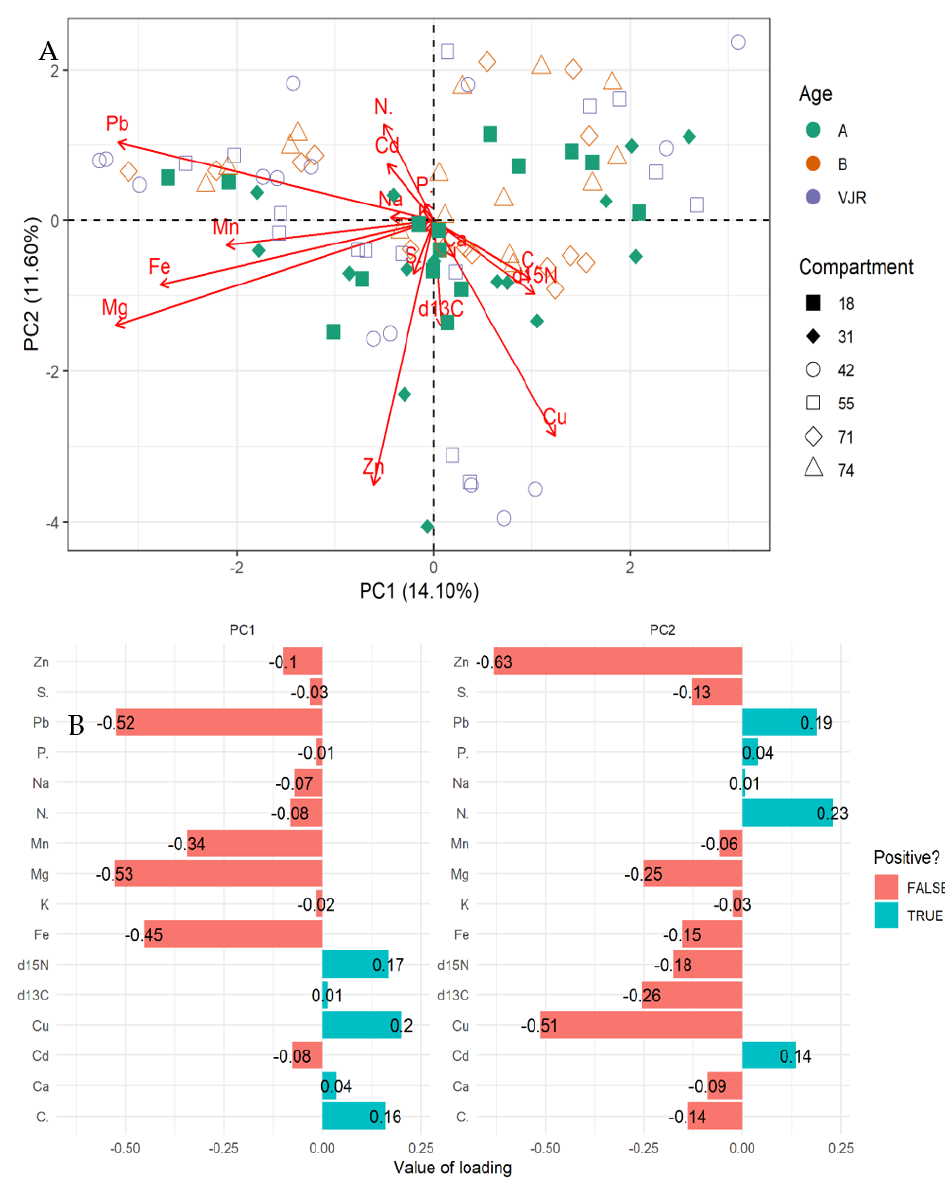
Figure 2. Relationship between elements in Rhizophora apiculata roots, compartment, and compart- ment ages in the Matang Mangrove Forest Reserve, as determined by principal component analysis biplot ( A ) and loadings ( B